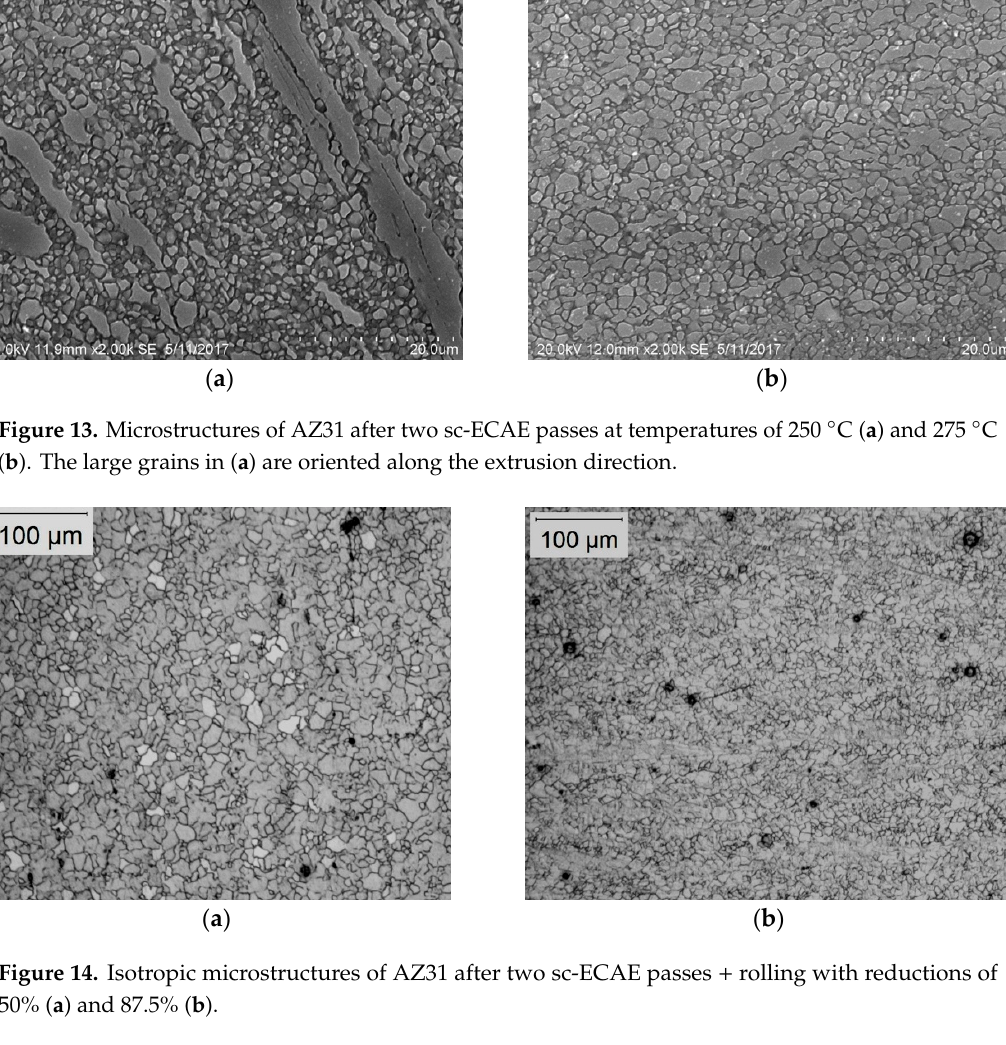
Figure 14. Isotropic microstructures of AZ31 after two sc-ECAE passes + rolling with reductions of 50% ( a ) and 87.5% ( b ).